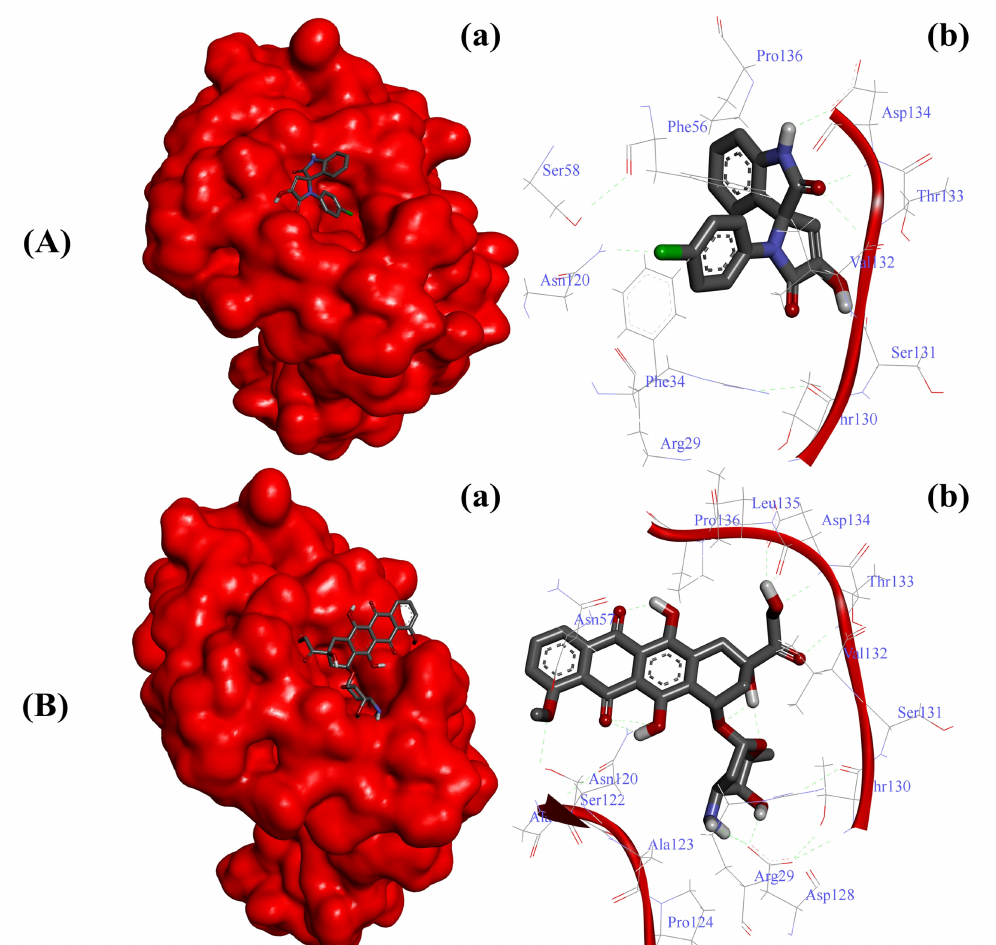
Figure 2. Substituted SOX ( 4a ) is a potent inhibitor of human CD44 (PDB ID: 1UUH). ( A ) Binding pattern of the substituted SOX ( 4a ) against human CD44 ( ∆ G: − 6.65 Kcal/mol); ( B ) Binding pattern of doxorubicin against human CD44 ( ∆ G: − 5.83 Kcal/mol). Subpanels ( a ) represent the interaction of 4a and doxorubicin inside the active pocket of the target protein (represented as a red surface). Subpanels ( b ) show the 2D image of the interacting residues of the CD44 with our